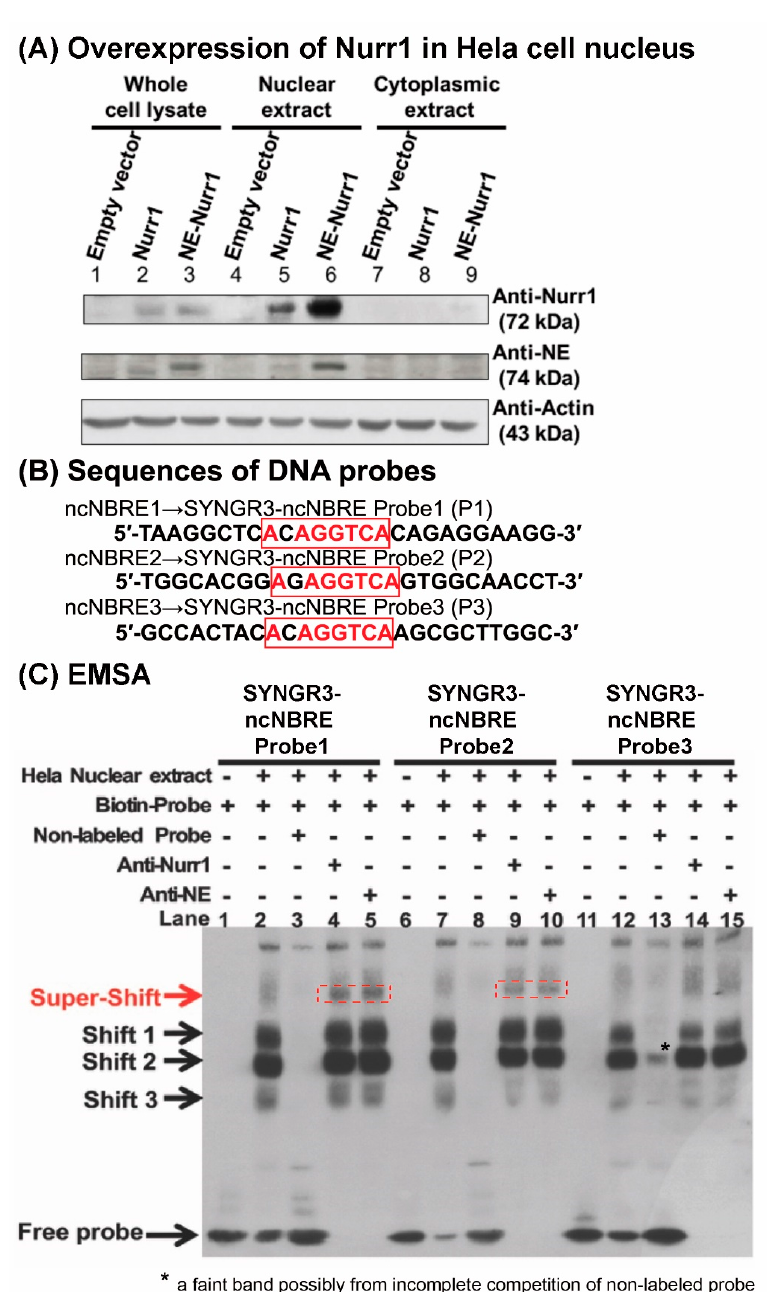
Figure 6. Probe design and gel shift assay of the three putative ncNBRE sites in the 5 ′ -flanking region of human SYNGR3. ( A ) Western blot analysis of NURR1 and NE-NURR1 expression in the whole cell lysate (lane 1–3), nuclear extracts (lane 4–6), and cytoplasmic extracts (lane 7–9) from NURR1 and NE-tagged NURR1 overexpressing and empty vector control Hela cells. ( B ) sequences of three DNA probes, with putative ncNBRE sites (red). ( C ) EMSA shows specific protein–probe binding indicated by shifted bands 1–3. The specificity of NURR1 binding was confirmed by supershift bands with both anti-NURR1 and anti-NE antibodies (red dashed boxes). “NE” is a synthetic protein tag attached to an overexpressed NURR1 protein in a nuclear extract.